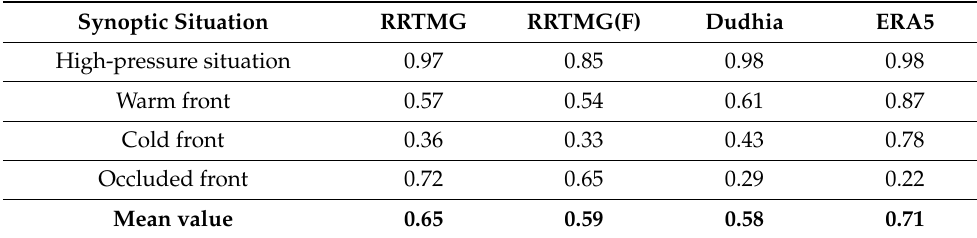
Table 11. Pearson’s correlation coefficients for individual synoptic